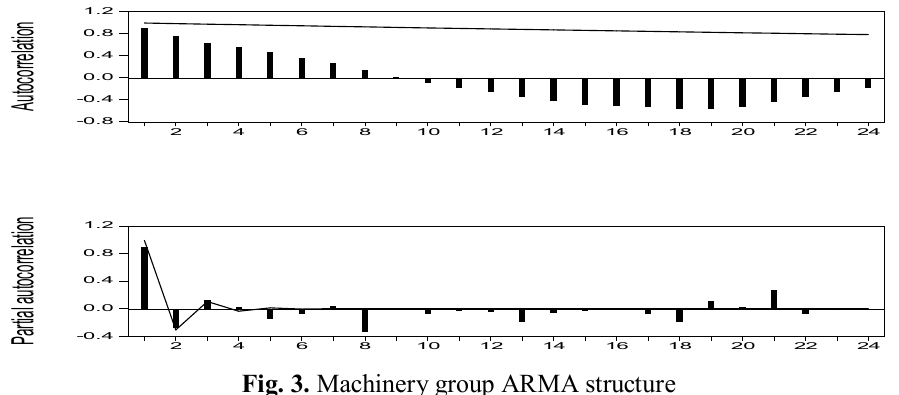
Fig. 3. Machinery group ARMA structure